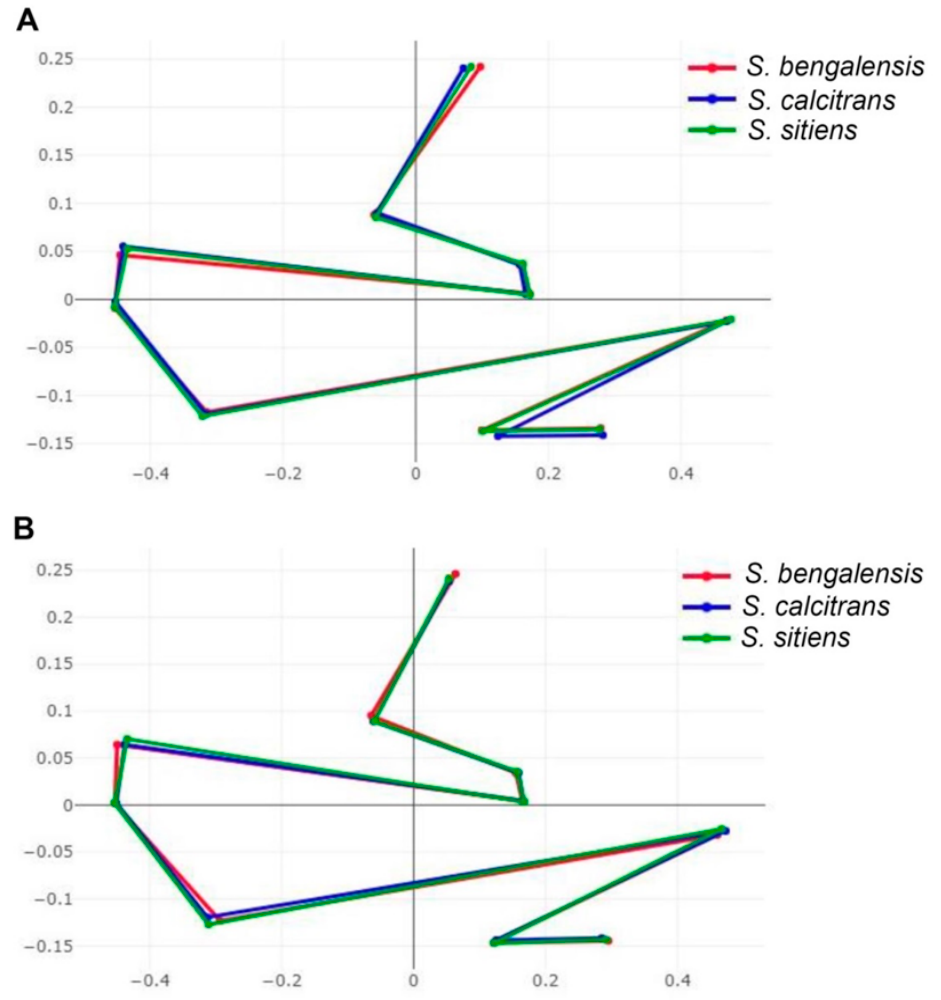
Figure 8. Superposition of the mean anatomical landmark positions of male ( A ) and female ( B ) Stomoxys bengalensis , S. calcitrans , and S. sitiens. ( B ) Stomoxys bengalensis , S. calcitrans , and S. sitiens